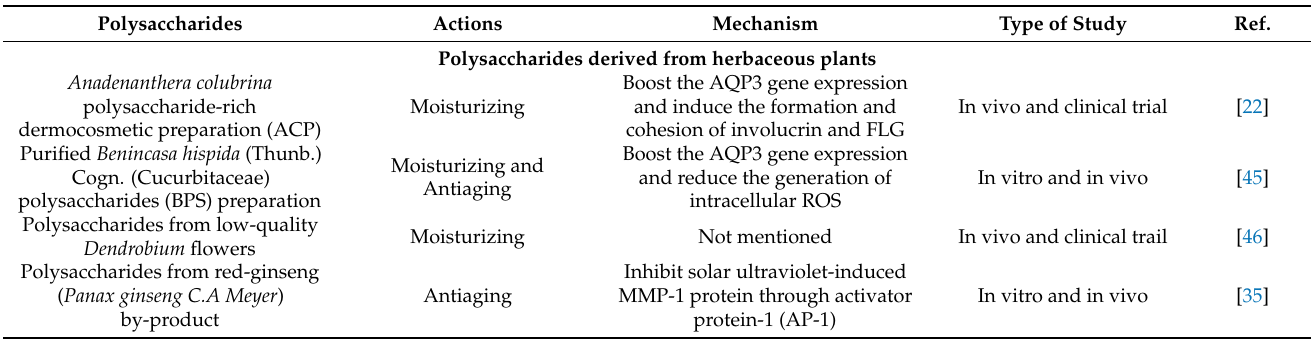
Table 1. Summary of skin actions of polysaccharides extracted from herbaceous plants, algae, and